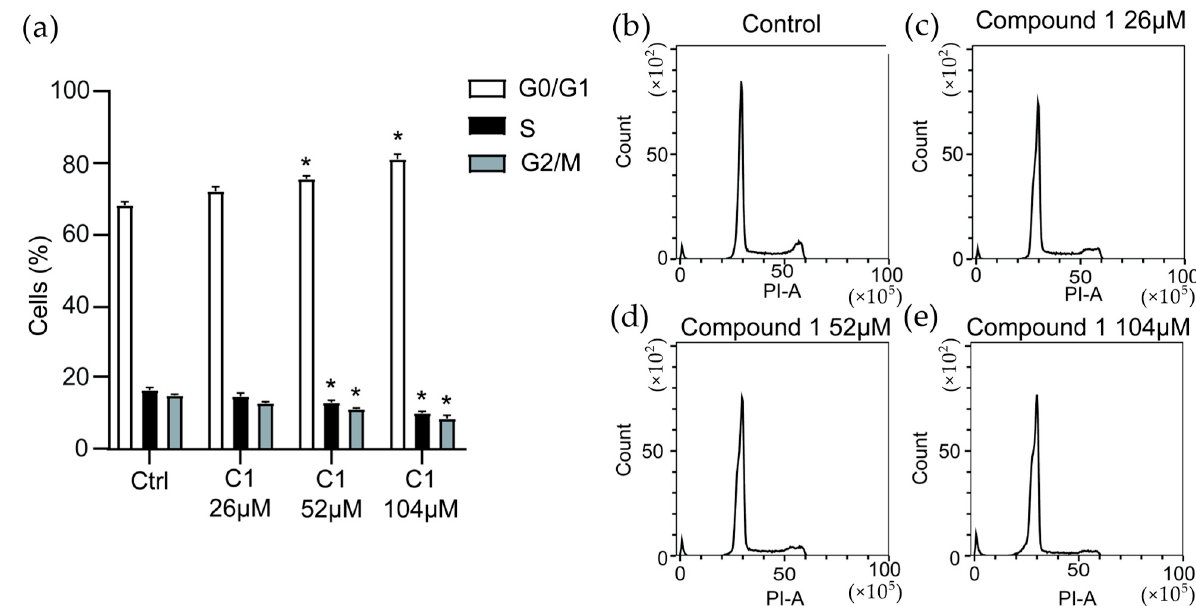
Figure 4. Cell cycle analysis. ( a ) MV-4-11 cells are significantly arrested in G0/G1 phase after treatment with 1 at 52 and 104 µM (2 × IC 50 and 4 × IC 50 , respectively) with a corresponding decrease in cells in S and G2/M phase when compared to control ( n = 3). ( b – e ) representative images of flow cytometry data. * denotes p ≤ 0.05.